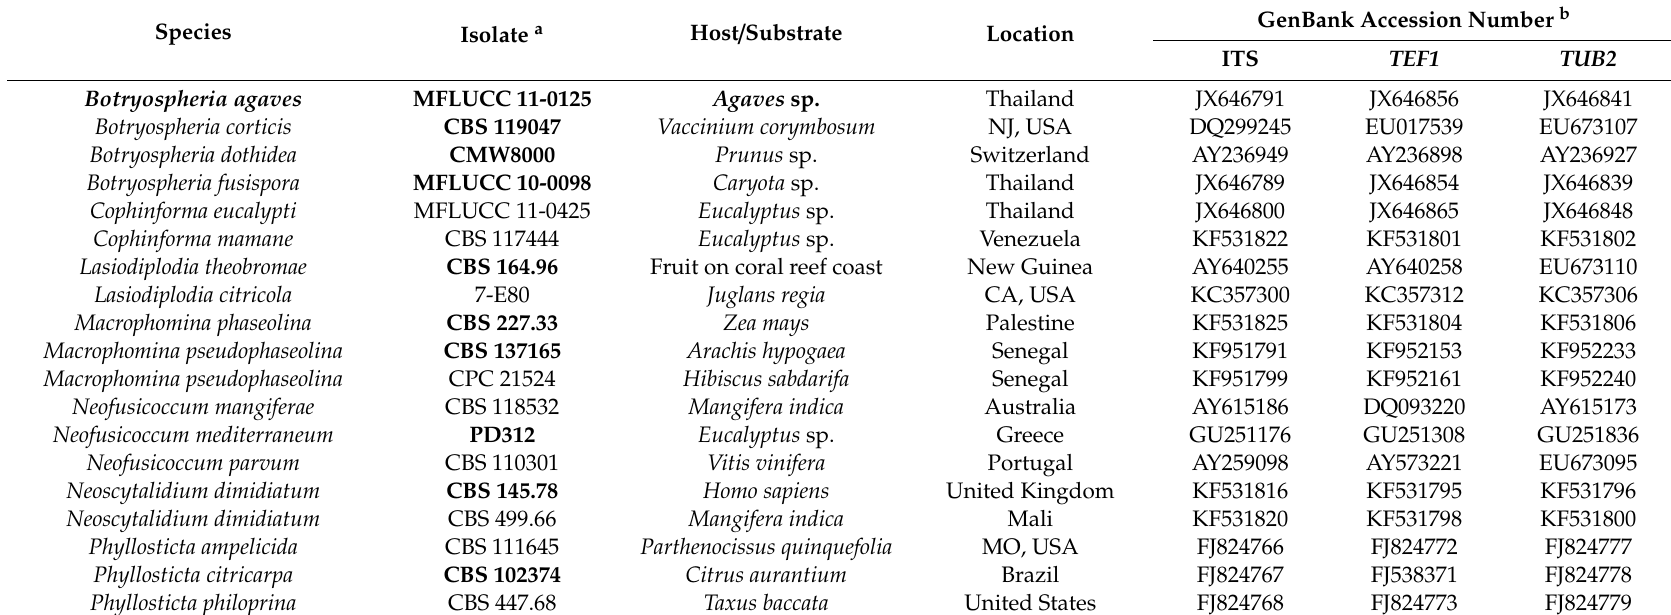
Table 2. Fungal isolates retrieved from Genbank for phylogenetic